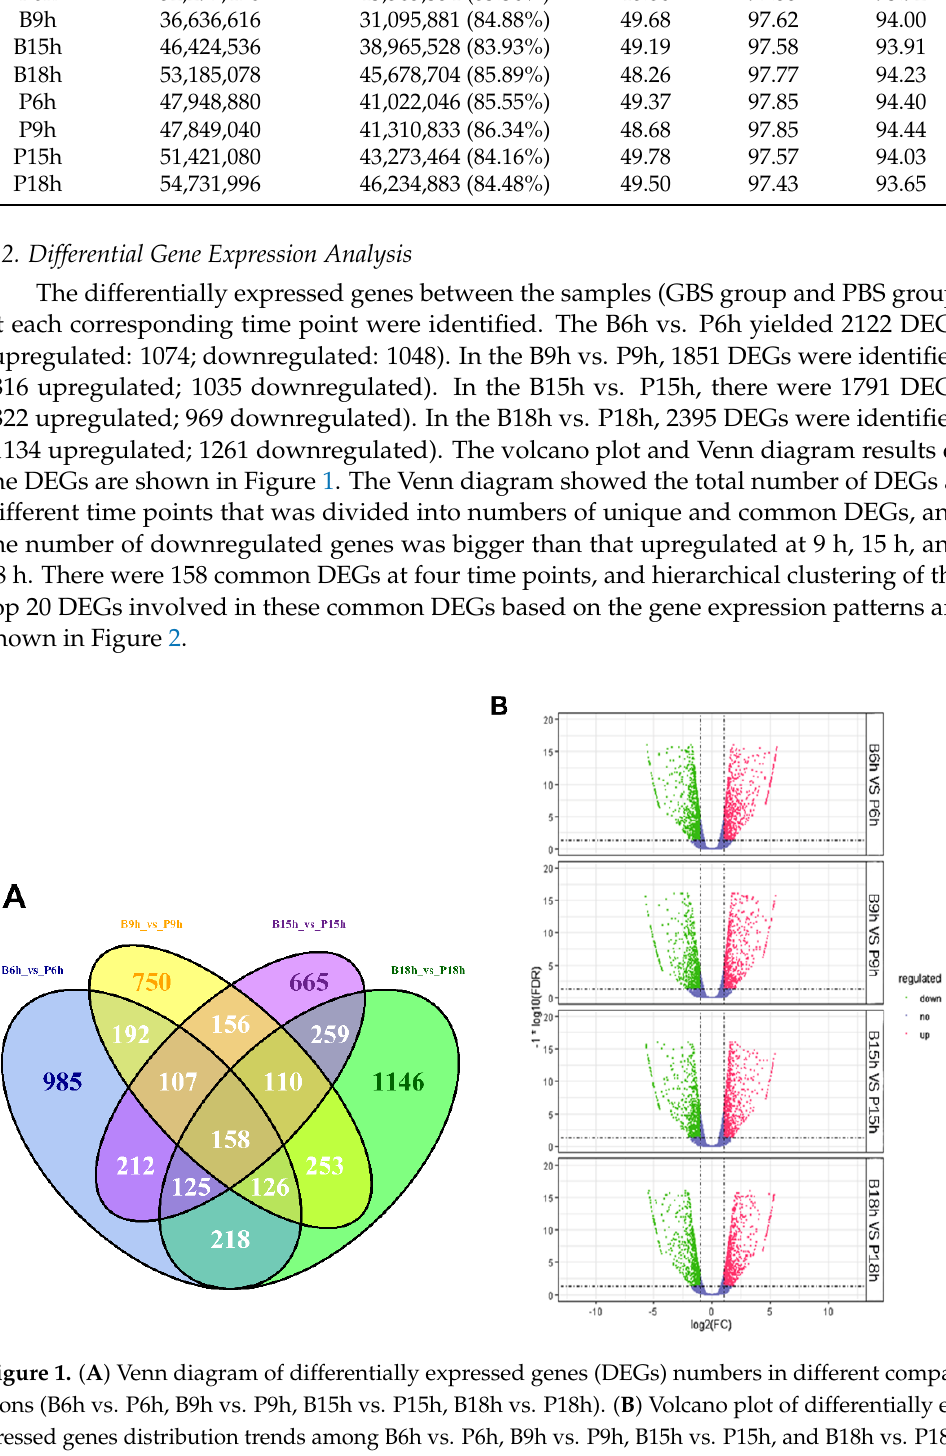
. Figure 2. Hierarchical clustering of the top 20 differentially expressed (DE) mRNAs among the nine libraries (C0h, P6h, P9h, P15h, P18h, B6h, B9h, B15h, and B18h). Heatmap of the count data for DE mRNA libraries for the differentially expressed genes.